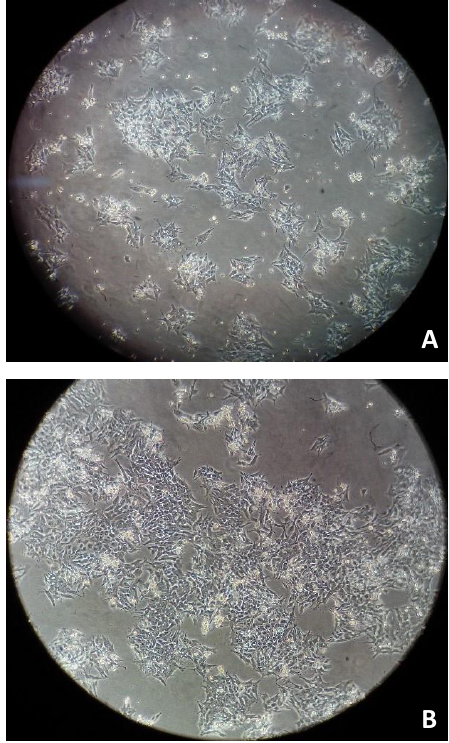
Figure 1. FMCm cells ( A ) with a confluency of 70%, 48 h, and ( B ) with a confluency of 80%, 72 h. All images were obtained through the optical microscope Lionheart™ FX Automated (20×).